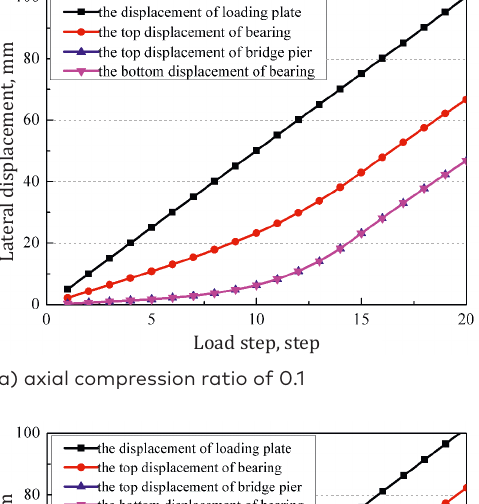
a) axial compression ratio of